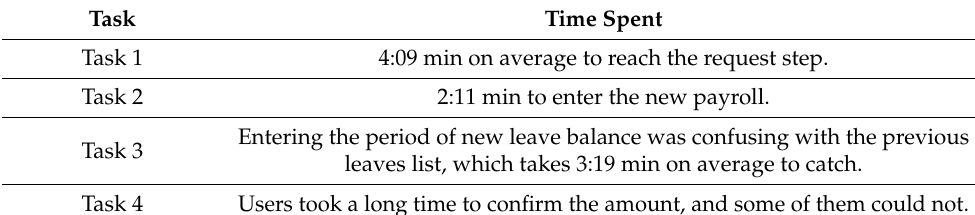
Table 7. Time calculated using the keylogger. Task Time Spent Task 1 4:09 min on average to reach the request step. Task 2 2:11 min to enter the new payroll. Entering the period of new leave balance was confusing with the previous Task 3 leaves list, which takes 3:19 min on average to catch. Task